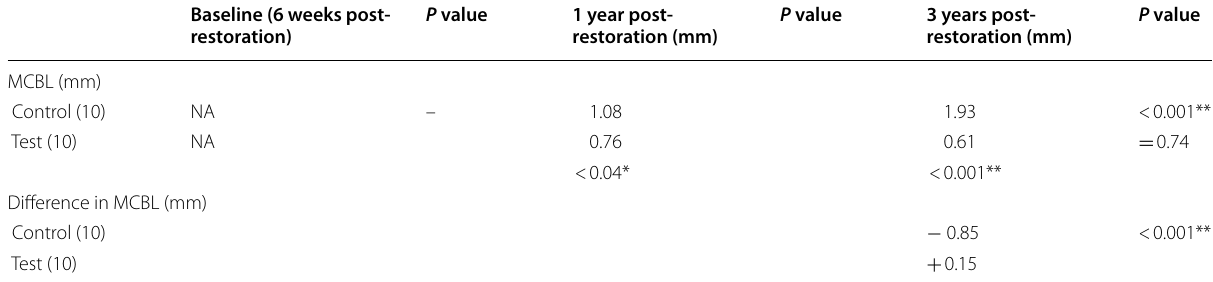
MCBL mean crestal bone loss, NA not